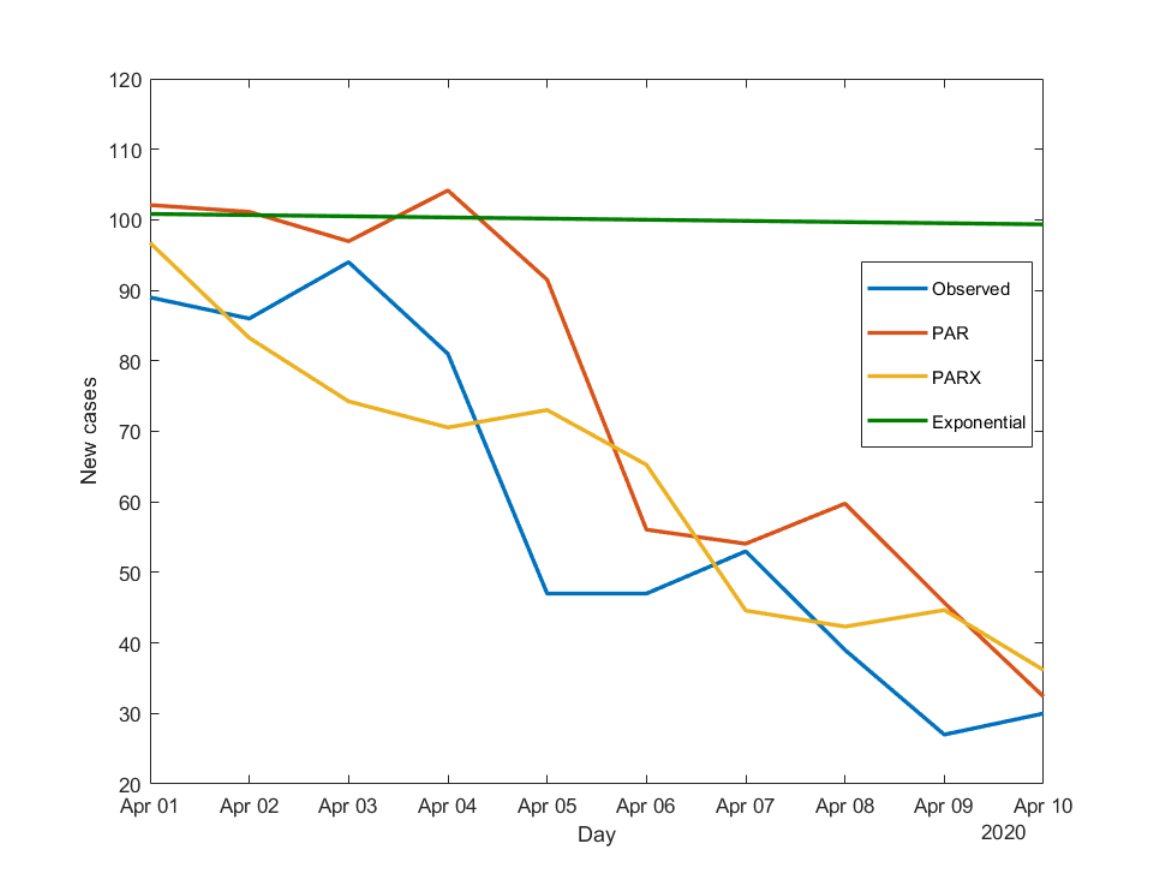
Figure 3. Daily infection counts in South Korea: observed and predicted